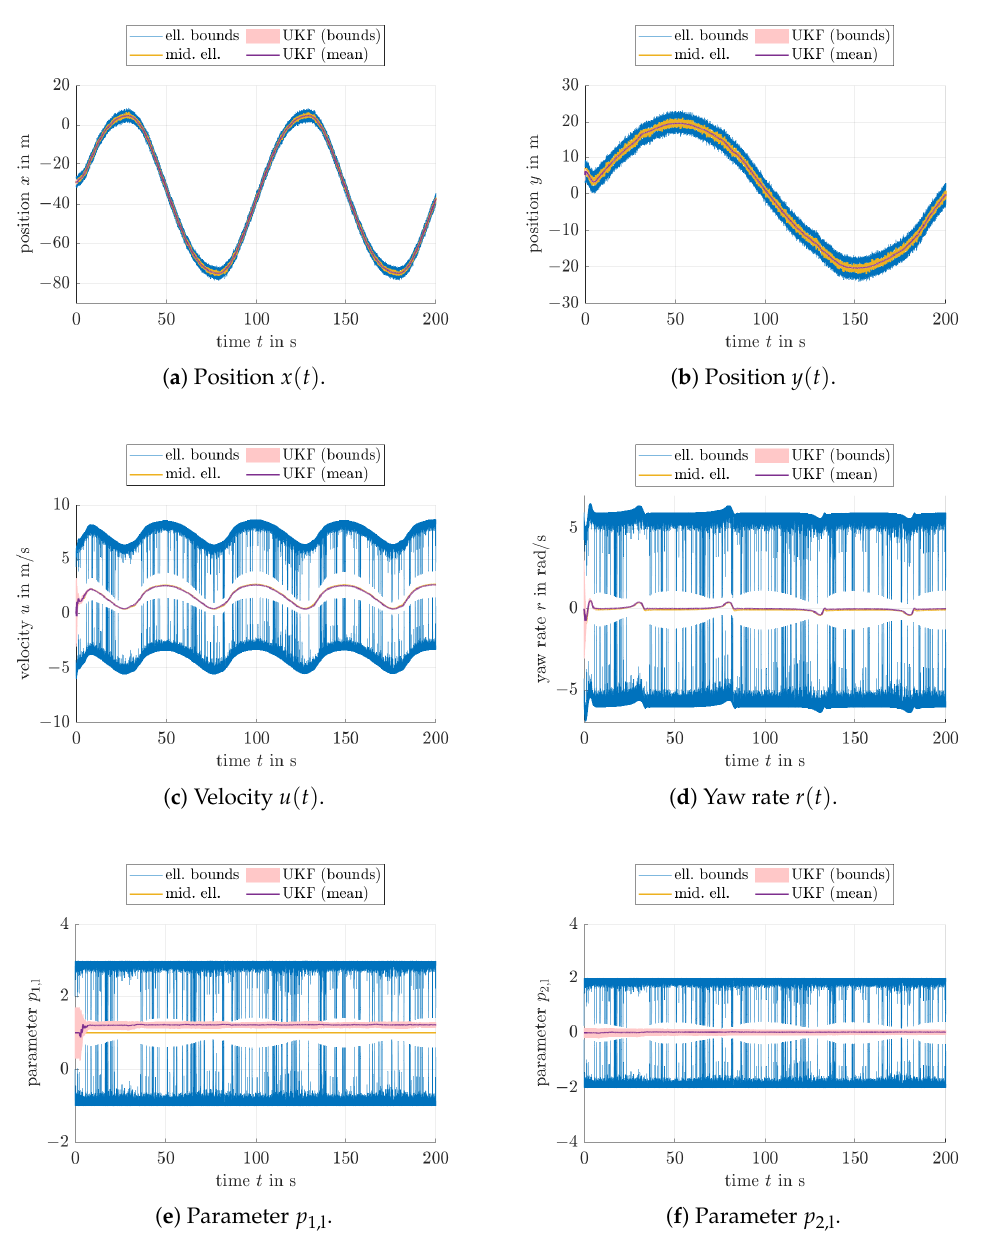
Figure 5. Estimation results with adaptation of the bounds for the uncertain system parameters: Scaling factor r = 4.2787 for the state prediction (95% confidence bound for n = 10) with 99% confidence bounds of process and measurement